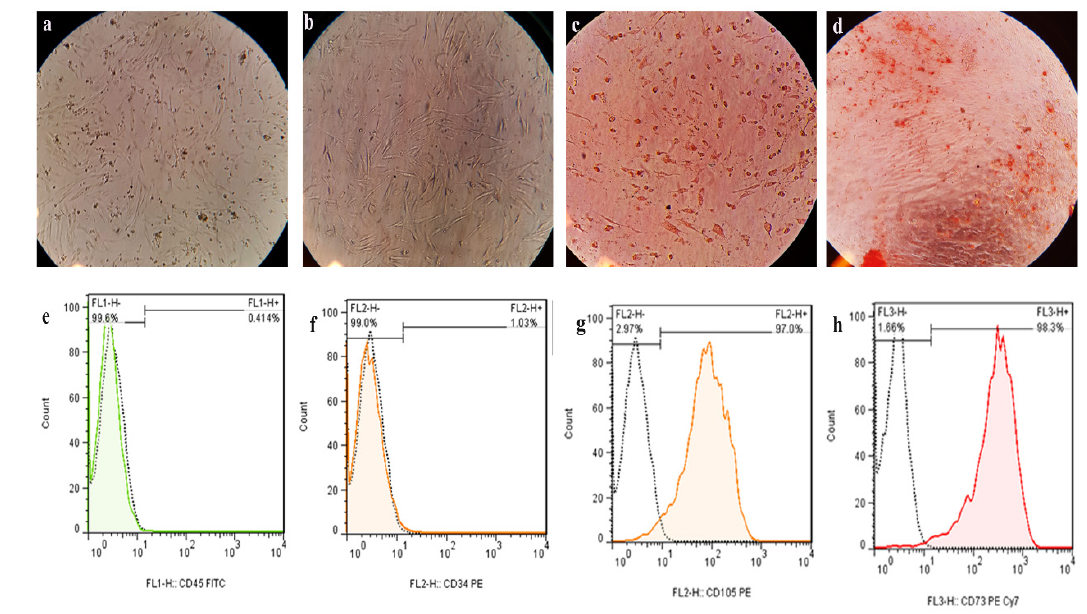
Figure 1. Inverted microscopy was used to examine the morphology of C-EnSCs. ( a ) C-EnSCs after the first culture. ( b ) C-EnSCs after the third culture. ( c ) C-EnSCs that differentiated into osteoblast cells and calcium storage deposits are marked in red. ( d ) C-EnSCs that differentiated into adipocytes after 21 days of treatment. Adipose vesicles are red. ( e – h ) Evaluation of C-EnSCs using flow cytometry after the third passage. ( e ) The expression level of the CD34 marker was about 0.41%. ( f ) The marker CD45 was expressed at about 1.03%. ( g ) The marker CD105 was expressed at about 97%. ( h ) CD90 marker was expressed at about 98.3%.